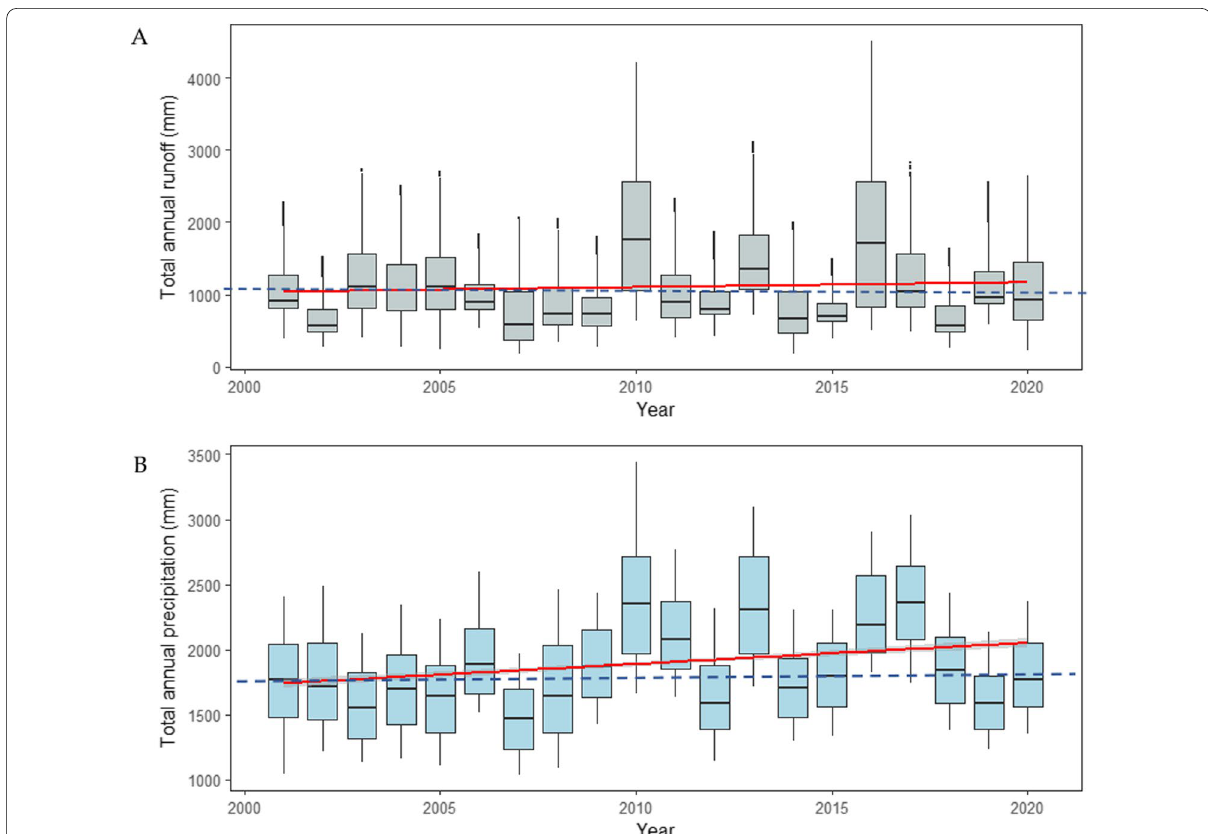
Fig. 5 Annual trend of surface runoff in Brantas watershed 2001–2020 as observed by TerraClimate ( A ) and total annual precipitation in Brantas 2001–2000 as measured from rain gauges ( B ). The red line represents the trend line of annual mean values, and the blue dashed line indicates the baseline of mean value in the reference year